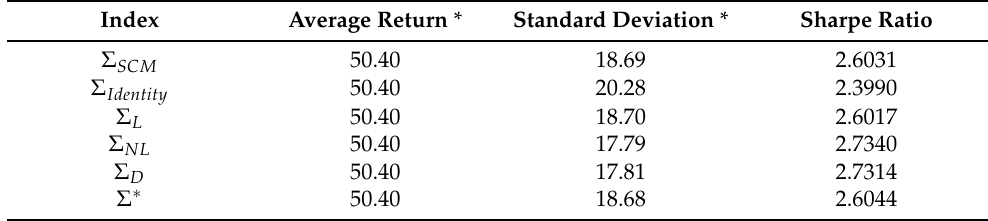
Table 7. The out-of-sample performance comparison between each estimations of the 218 assets in HS300.